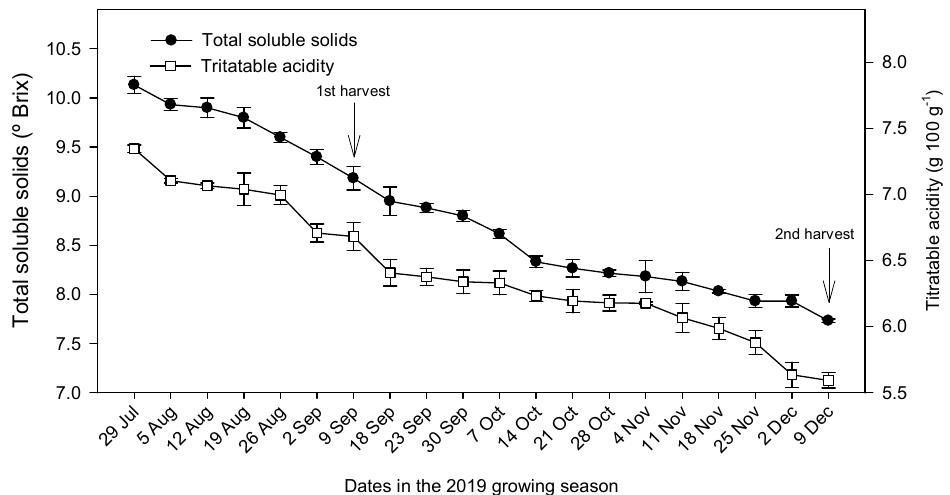
Figure 6. Evolution of total soluble solids and titratable acidity content at the left and right axes, respectively, in lemon fruits during development and on-tree ripening in the 2019 growing season.